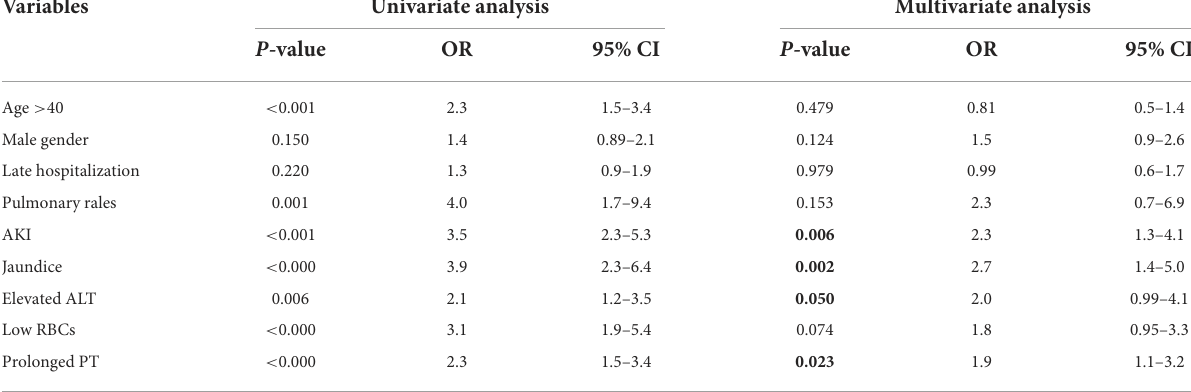
TABLE 4 Univariate and multivariate logistic regression analysis to determine the predictors (risk factors) for prolonged hospitalization of leptospirosis. Variables